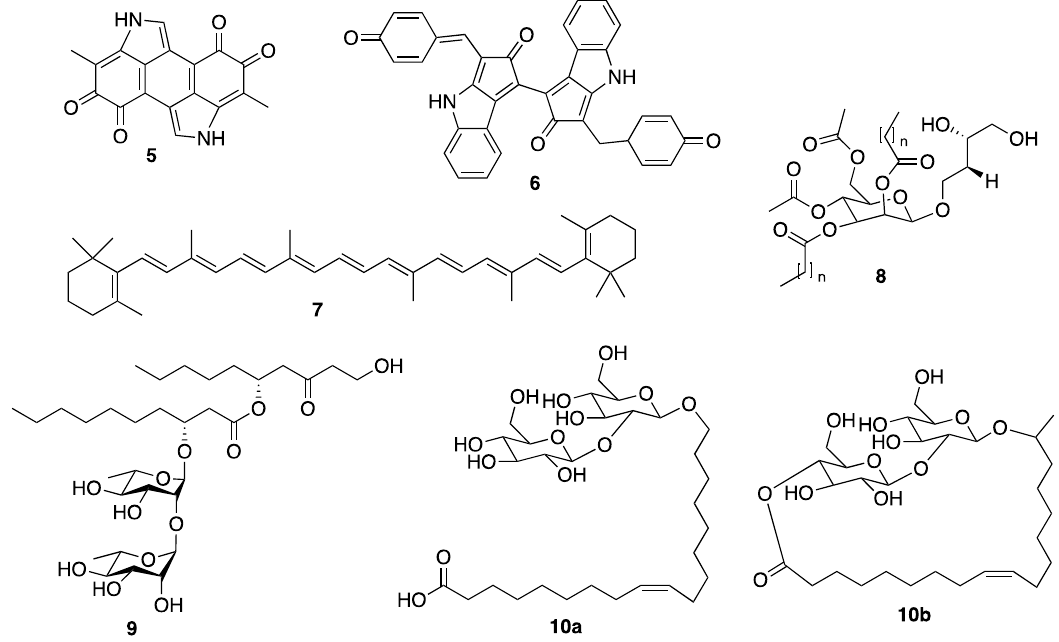
Figure 2. The structures of melanin ( 5 ), scytonemin ( 6 ), β -carotene ( 7 ), mannosylerythritol ( 8 ), rhamnolipid ( 9 ), and sophorolipids (free acid type (10a ) and lactone type (10b )). rhamnolipid ( 9 ), and sophorolipids (free acid type ( 10a ) and lactone type ( 10b